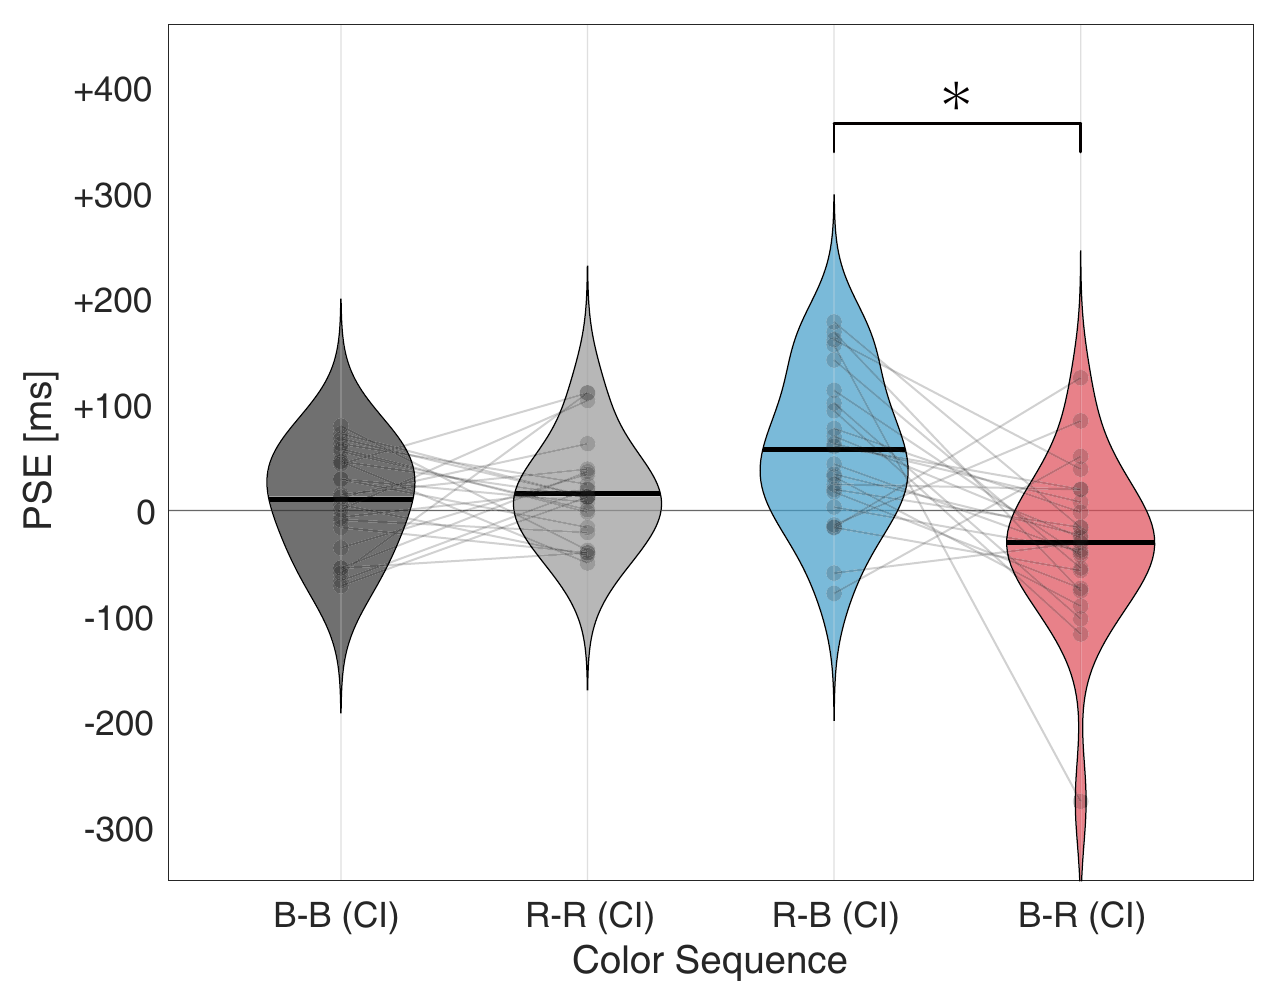
Fig 3. Mean PSE of each color sequence. Violin plots of mean PSE as a function of stimulus sequence. The plots show the data distribution with a solid black line for the mean of the data. The overlaid semitransparent dot indicates the mean value for each participant’s data. � Indicates statistically significant ( p < 0.05) differences in the analysis of variance and post-hoc testing. Abbreviations: B–blue, R–red, CI–comparison interval, PSE–point of subjective equality.